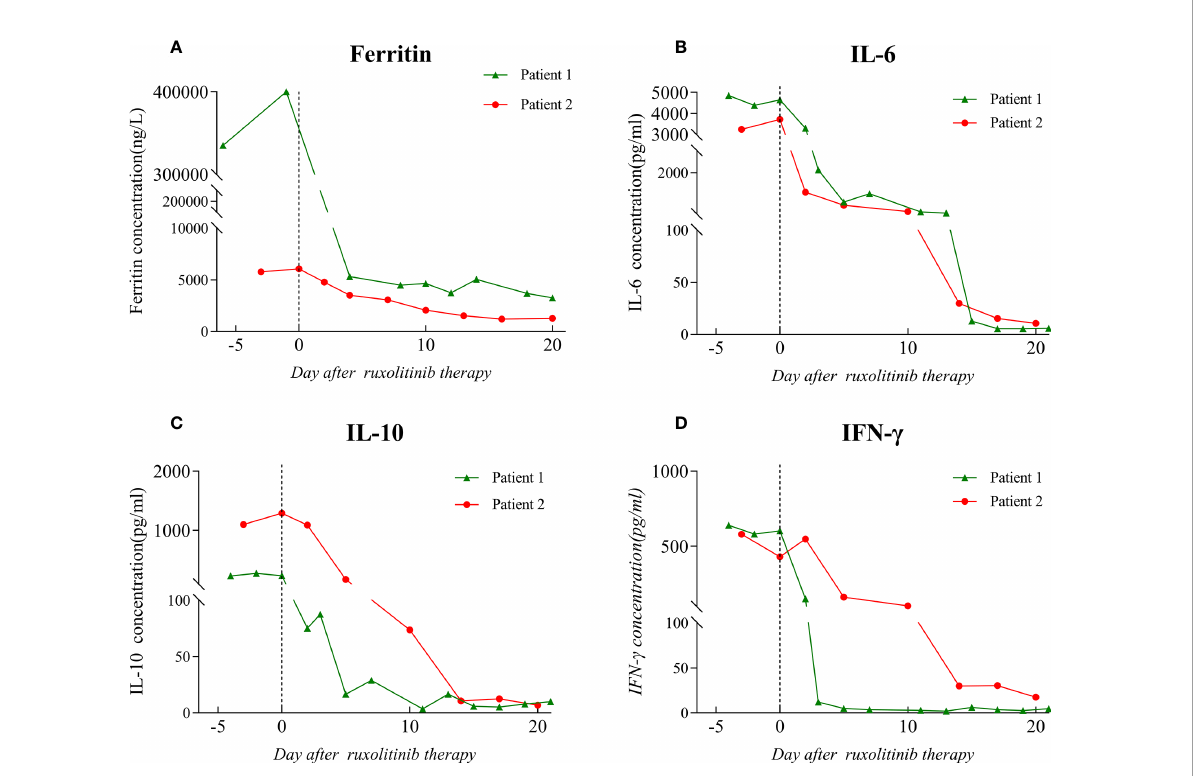
FIGURE 2 Ferritin and cytokine level before and after the initiation of ruxolitinib treatment. The dotted line on the graph indicates the day on which ruxolitinib treatment was started. (A) Ferritin level. (B) IL-6 level. (C) IL-10 level. (D) IFN- g level. IL: interleukin; IFN: